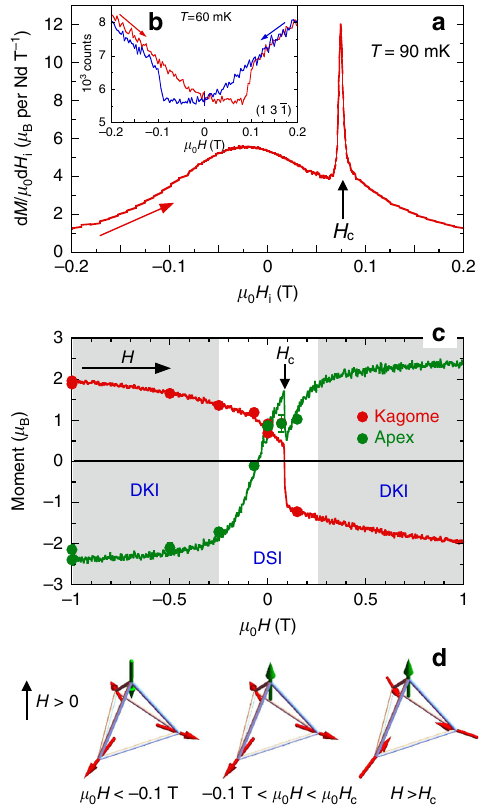
Fig. 2 Field evolution of the magnetic structure for H || [111]. a Derivative of the magnetization d M /d H i vs the internal magnetic fi eld H i when H is swept from negative to positive. b Field dependence of the ð 13 (cid:1) 1 Þ Bragg peak intensity when sweeping the fi eld from negative to positive (red) and back (blue). c Re fi ned magnetic moment for the apex (green) and kagome (red) spins of a tetrahedron as a function of fi eld. Points correspond to data collections. The error bars are provided by the Rietveld re fi nement made using Fullprof. Lines are obtained from the analysis of the fi eld sweeping measurements where the moment values have been rescaled to the re fi ned values obtained from the data (see Supplementary Figures 2 – 4 and Supplementary Note 1). The obtained moments are aligned along the 〈 111 〉 directions. By convention, for an up tetrahedron, a positive (negative) moment value corresponds to an out (in) moment. The regions where a dynamic kagome ice state (DKI) is stabilized are colored in gray. At low fi eld, the dynamic spin ice state (DSI) is observed. d Schematic of the magnetic structure of the three observed con fi gurations for an up tetrahedron: (i) 1 in − 3 out for μ 0 H < − 0.1 T, (ii) all out around H = 0, (iii)